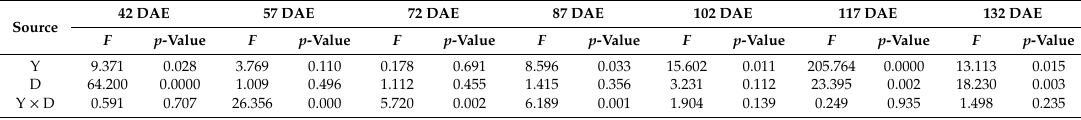
Table 7. Analysis of variance for the e ff ect of year (Y) and plant density (PD) on dry matter partitioning.